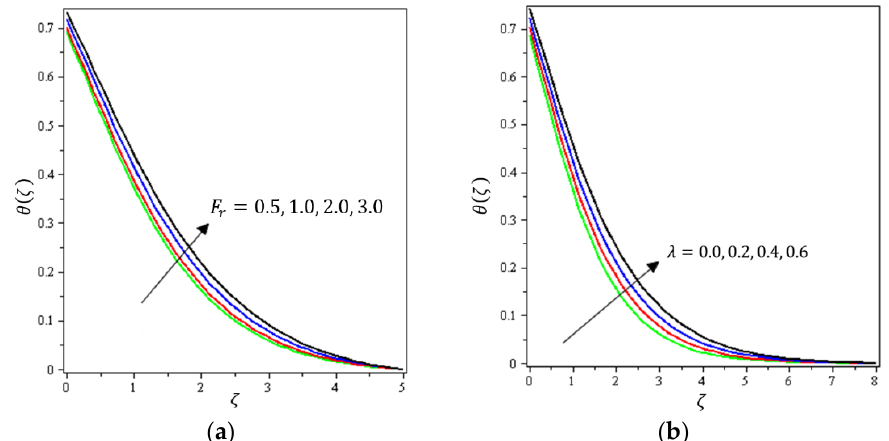
Figure 6. Influence of ( a ) Darcy–Forchheimer F r and ( b ) Prandtl number Pr on θ ( ζ ) .